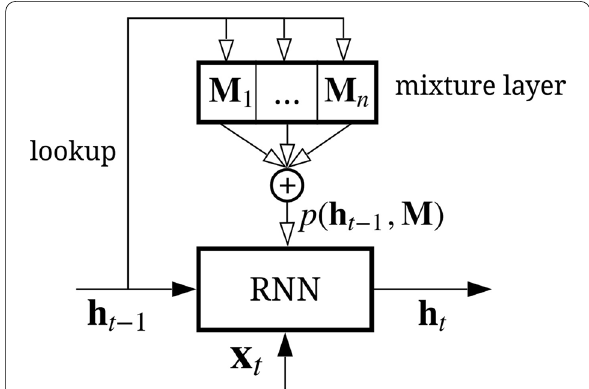
Fig. 3 Architecture of mixture layer in adaptive recurrent neural network. Here, M 1 , ... , M n denote the patterns extracted from the training